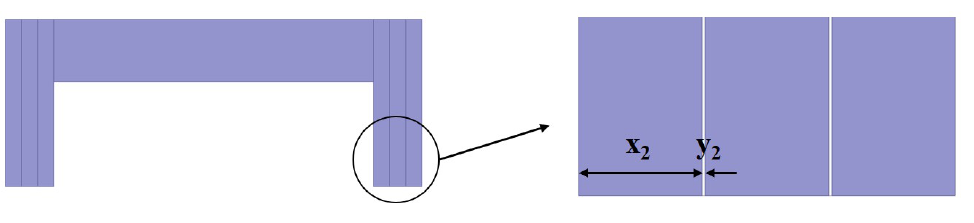
Figure 12. Cross section of type-II rail.